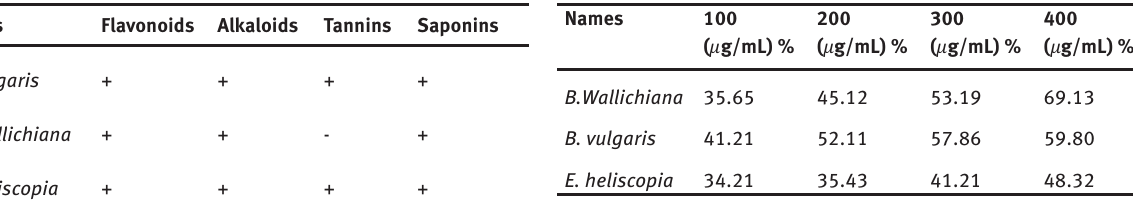
Table 5: Qualitative phytochemical analysis of the plant species studied using alcoholic plant extracts.